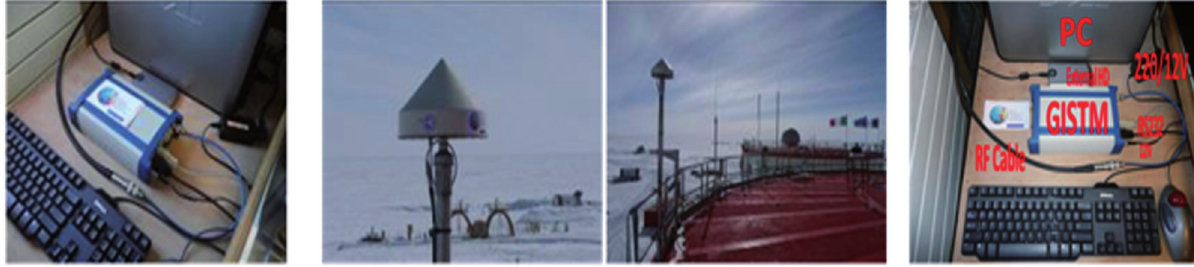
Figure 3. The ISACCO-DMC0 station installation (latitude, 75.1001°S; longitude, 123.333°E, 3280 m a.s.l.).